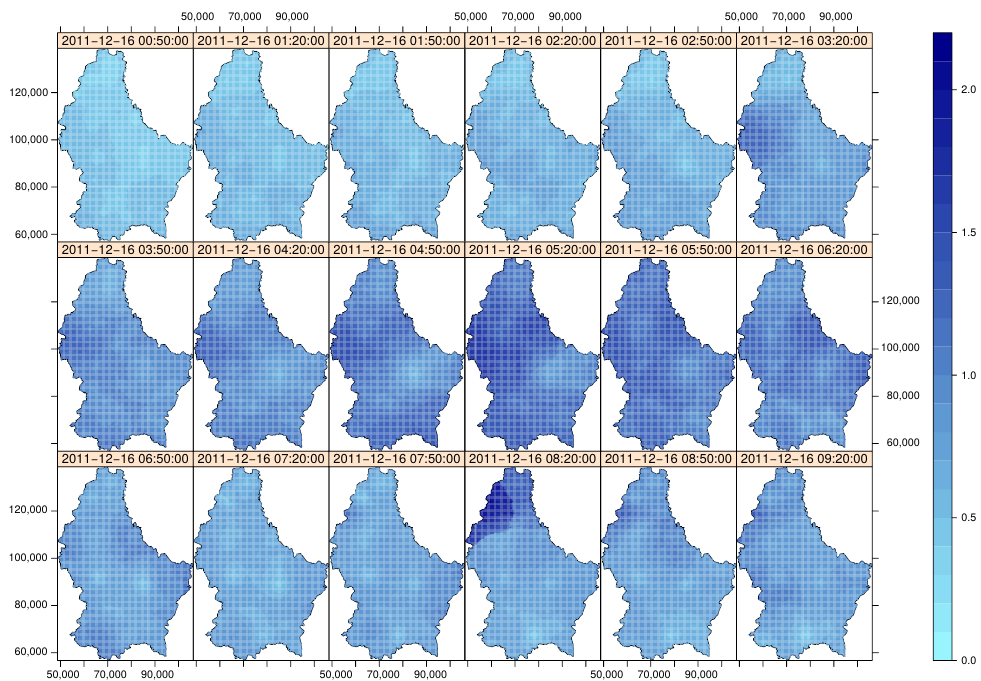
Figure 10. Predictions obtained with the spatio-temporal sum-metric model (upper boundary of the 90 percent prediction